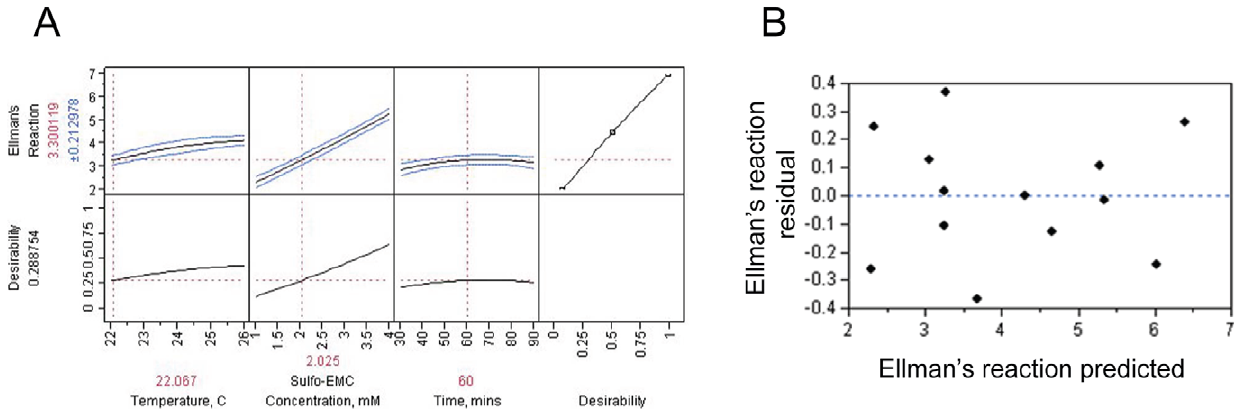
Figure 2. Multi-parameter analysis of linker substitution. Response curves for the analysis of temperature, modifier concentration and time on the linker substitution of EPA using a Box-Behnken model (A). Residual plot of the Ellmans’ reaction showing there is no systematic pattern (B). A linear regression model was used for analysis given the following assumptions: relationships between dependent and independent variables are linear, no serial correlation, the response variables are normally distributed, and have the same